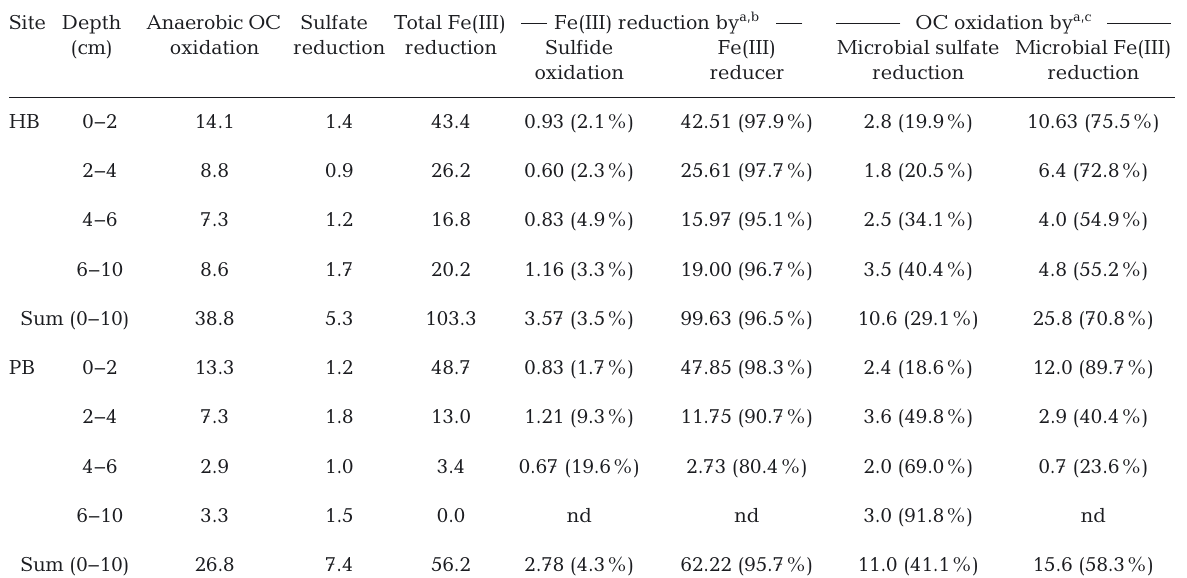
Table 3. Partitioning of sulfate and Fe(III) reduction in anaerobic organic carbon (OC) oxidation (mmol m −2 d −1 ). HB: